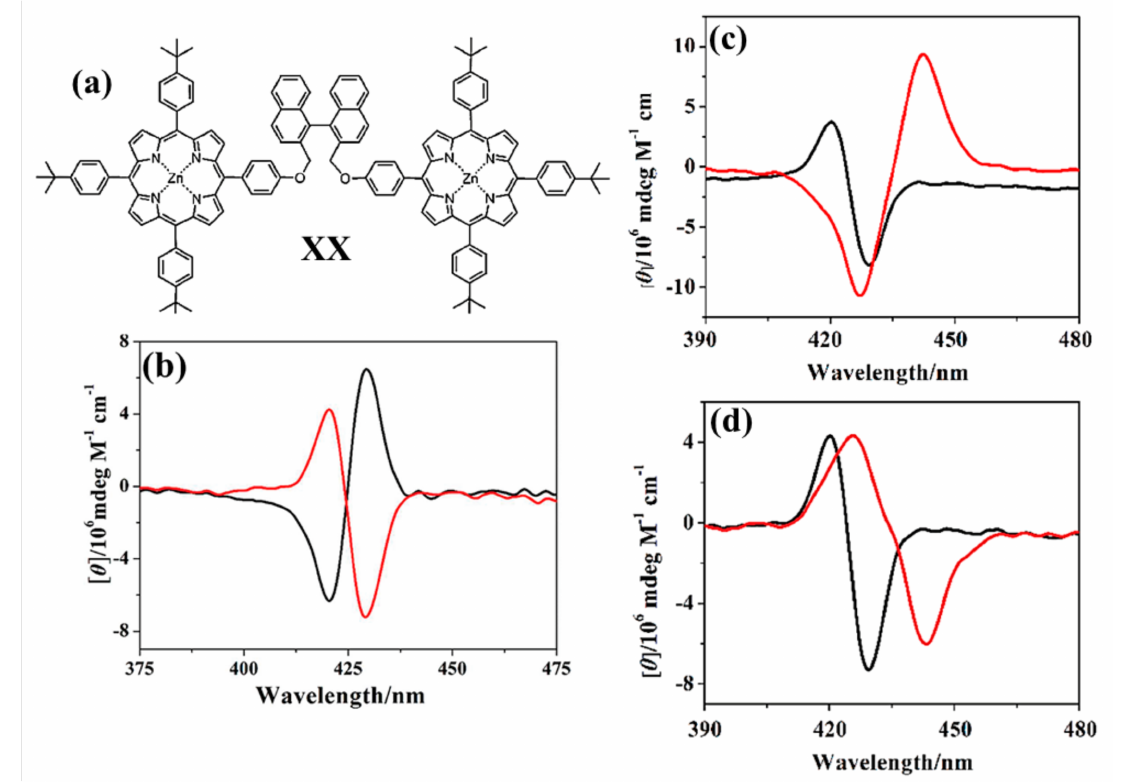
Figure 17. ( a ) Molecular structure of the chiral bis-porphyrin XX ; ( b ) CD spectra of the two enantiomers of bis-porphyrin (R-, red curve, S-, black curve); ( c ) CD spectra of (R)-enantiomer of bis-porphyrin alone (black curve) and after (red curve) the addition of (1S, 2S)-diaminecyclohexane; ( d ) CD spectra of (R)-enantiomer of bis-porphyrin alone (black curve) and after (red curve) the addition of (1R, 2R)-diaminecyclohexane. Adapted with permission from reference [80]; published by American Chemical Society